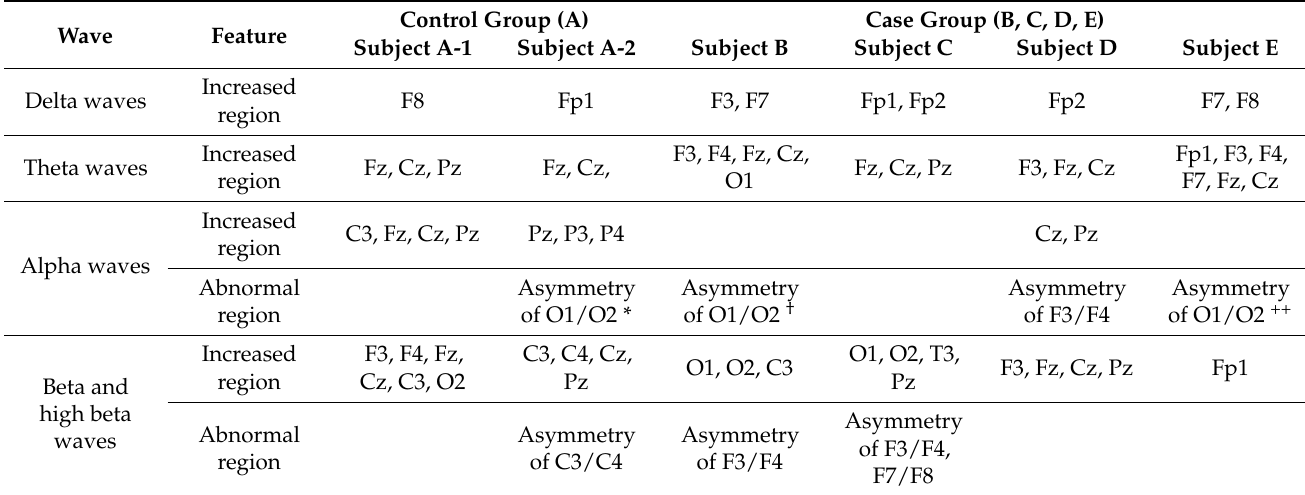
Table 6. Summary of topographical brain map findings by wave